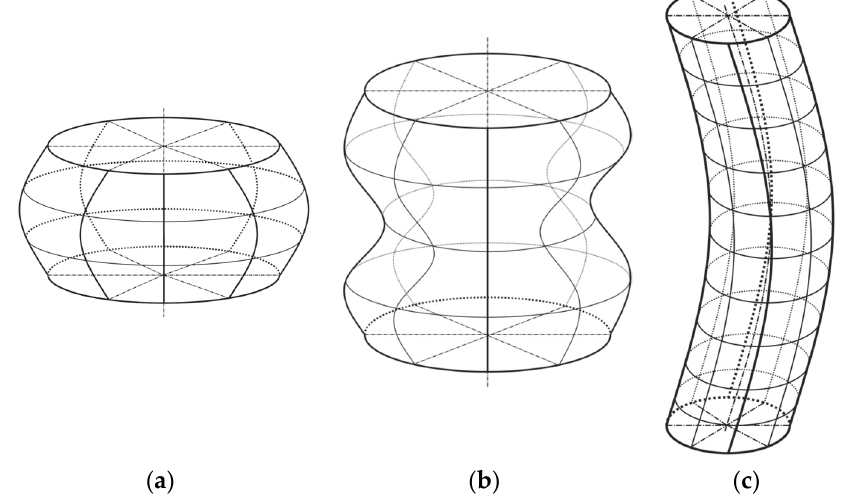
Figure 2. Collapsed shapes of: ( a )—short; ( b )—medium; ( c )—long shell classes. The field of investigation for the loss of stability of thin-walled shells focuses on cy- lindrical shells with an elliptical cross-section. The task is to determine the influence of the elliptical cross-sectional area on the achieved critical force value. Four fixtures are de- signed to provide the desired elliptical cross-section along the entire length of the test specimen. The size of the ellipses examined was defined by a parameter referred to as eccentricity (cid:1857) . The relation determining (cid:1857) is defined as (cid:1857) = (cid:3496)1 − (cid:1854) (cid:2870) (cid:1853) (cid:2870) (4) where, the designations (cid:1853) , (cid:1854) represent the ellipse arms. Thin-walled shell elements are specific in that they can carry significantly higher loads than other thin-walled elements. In order to minimize this positive property of the shells, a can designed for storing carbonated beverages with a volume of 0.5 L , was cho- sen for the production of test specimens. In order to make a correct test specimen from the can, it was necessary to remove both ends of the can in precisely defined places. These points are located behind the can rounding, where the shell has constant diameter and cross-sectional surface thickness is identical, Figure 3. Figure 3. Can and manufactured specimen.